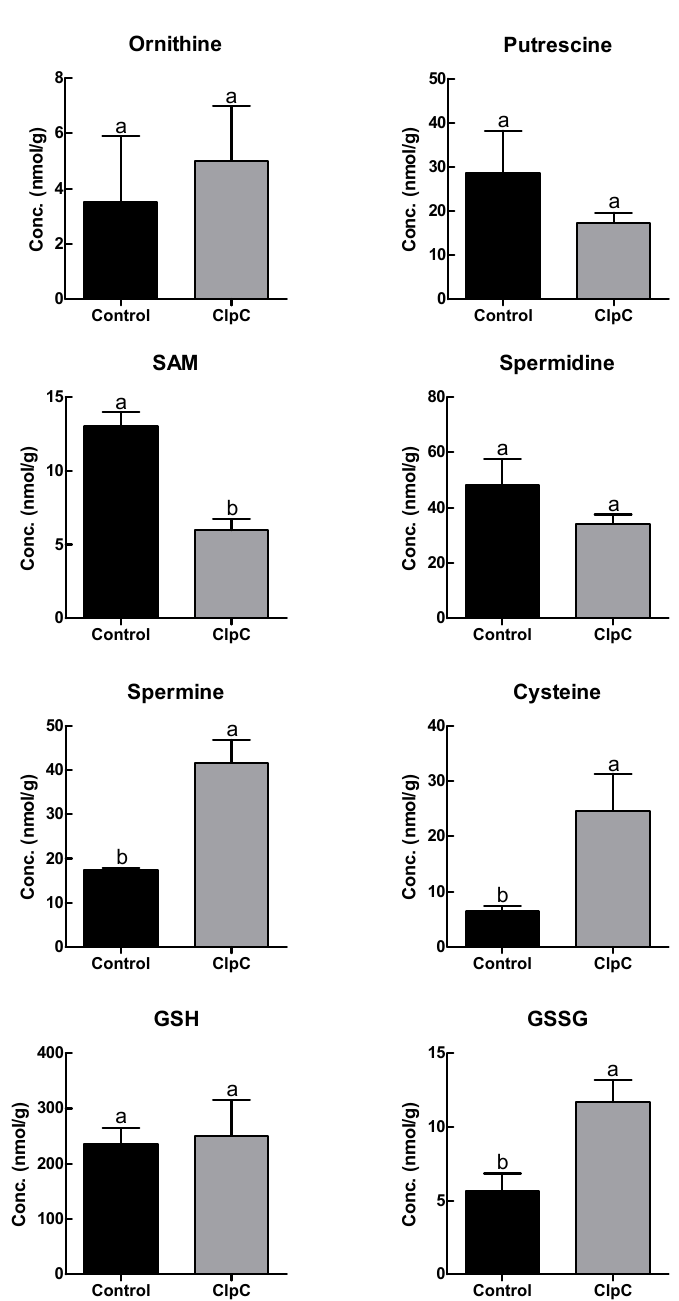
Figure 5. Changes in polyamine and antioxidant metabolite contents with co-suppression of NbClpC1 / C2 in Nicotiana benthamiana plants. ClpC: NbClpC1 / C2 co-suppressed plants. SAM, S-adenosyl methionine; GSH, reduced glutathione; GSSG, oxidised glutathione. The error bars indicate the SD of triplicate samples. The di ff erent letters on the bars indicate statistically significant di ff erences between groups ( p <0.05).